Question: What caption would you write for this figure?
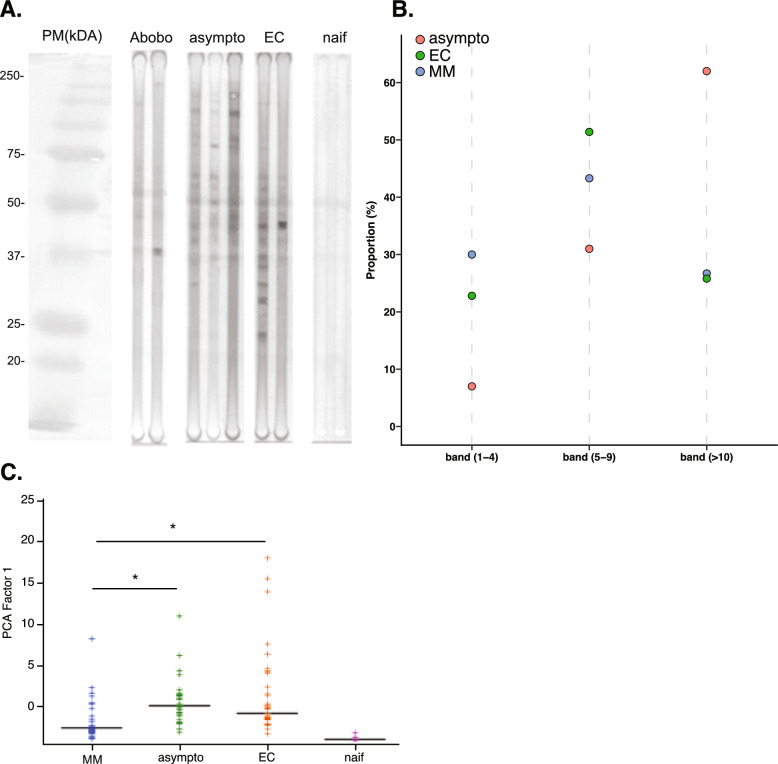
Answer: Profiles of IgG reactivities to brain antigens in the different participant groups from Abobo. A Example immunoblot profiles of sera reactive to brain antigens from EC, AS, and MM participants. Each strip contains approximately 10 µg of human brain extract; MW, molecular-weight marker; malaria-naïve, European control sera from individuals with no history of malaria exposure. B Percentage of individuals in each clinical group distributed according to the number of reactive bands (1–4, 5–9, and > 10). C PCA factor 1 score from adjusted IgG reactivity profiles. Asterisks indicate statistically significant differences between groups (* p < 0.05; ** p < 0.01; *** p < 0.001)